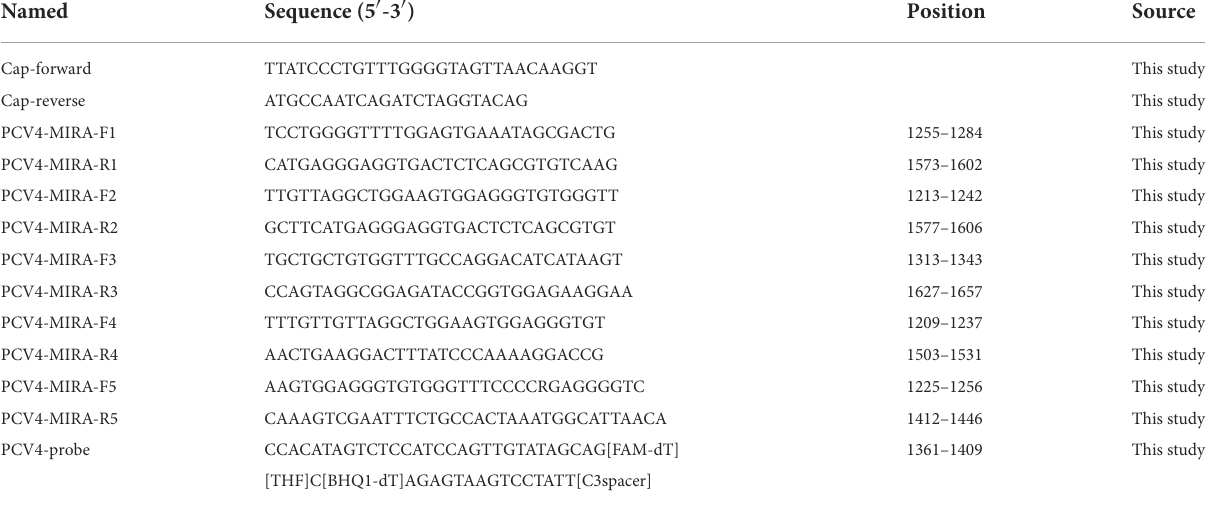
TABLE 1 Primers and probe sequences of PCV4 used in this